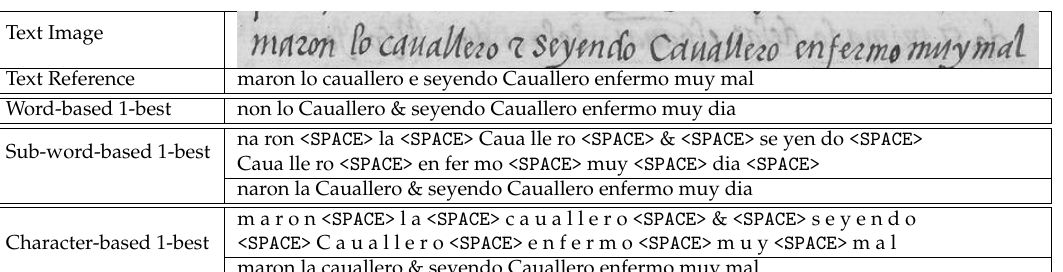
Figure A2. Example of the best hypotheses obtained for the 9th line of page 619 of Rodrigo .